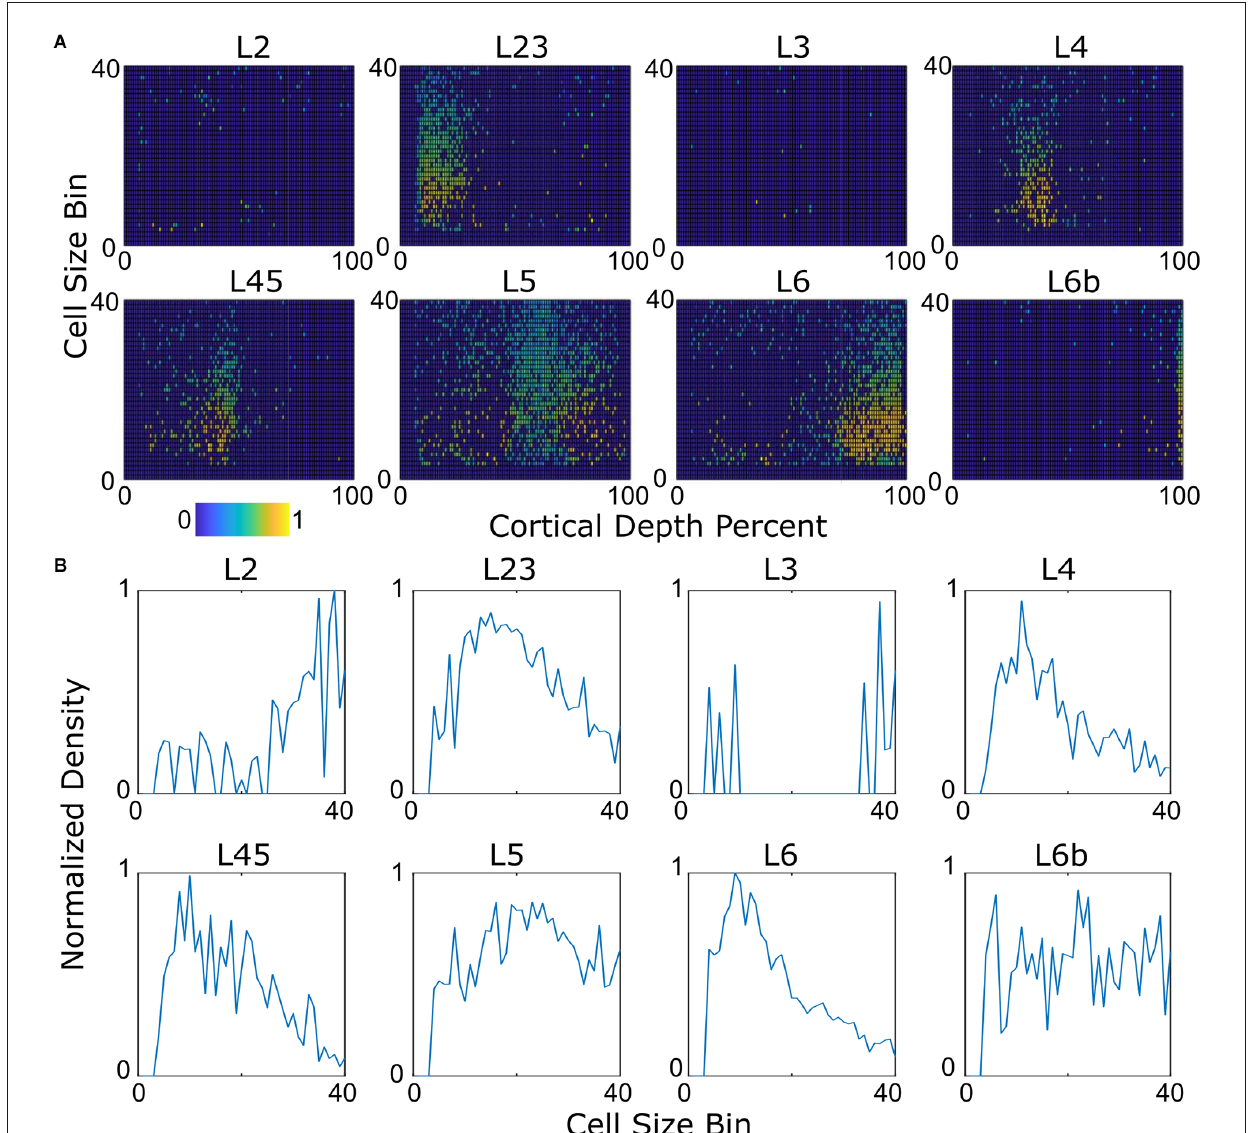
FIGURE6 Characteristic size distributions. (A) The distribution plotted in area-depth bins. L2 and L3 cells do not have a coherent pattern, indicating that the method may not correctly place them. (B) Average size distribution kernels. Differences in the kernels are observed. L4 cells tend to be slightly smaller than L5 cells, for